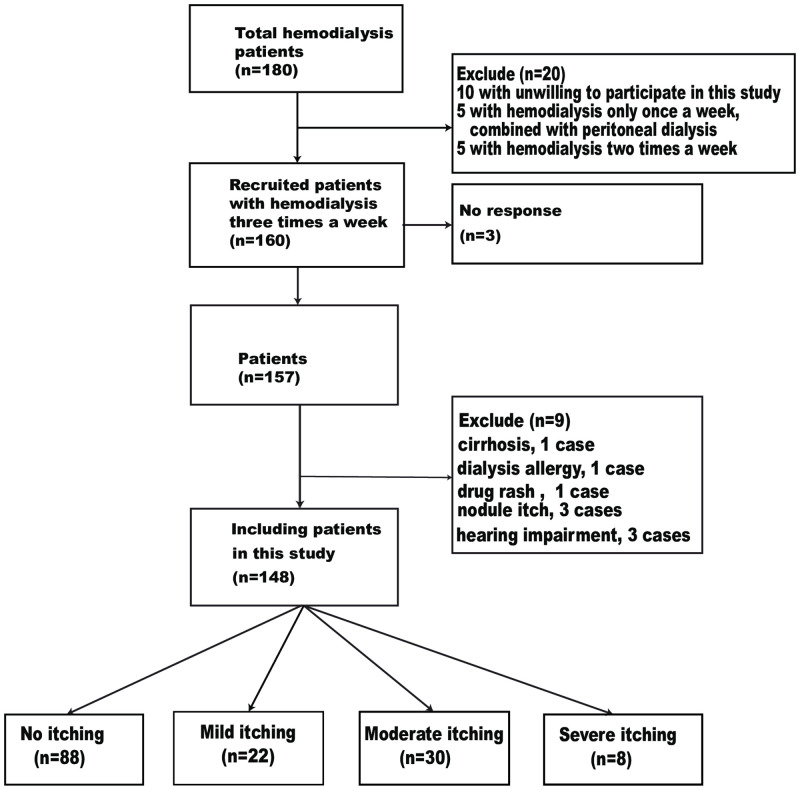
Patient screening and grouping.